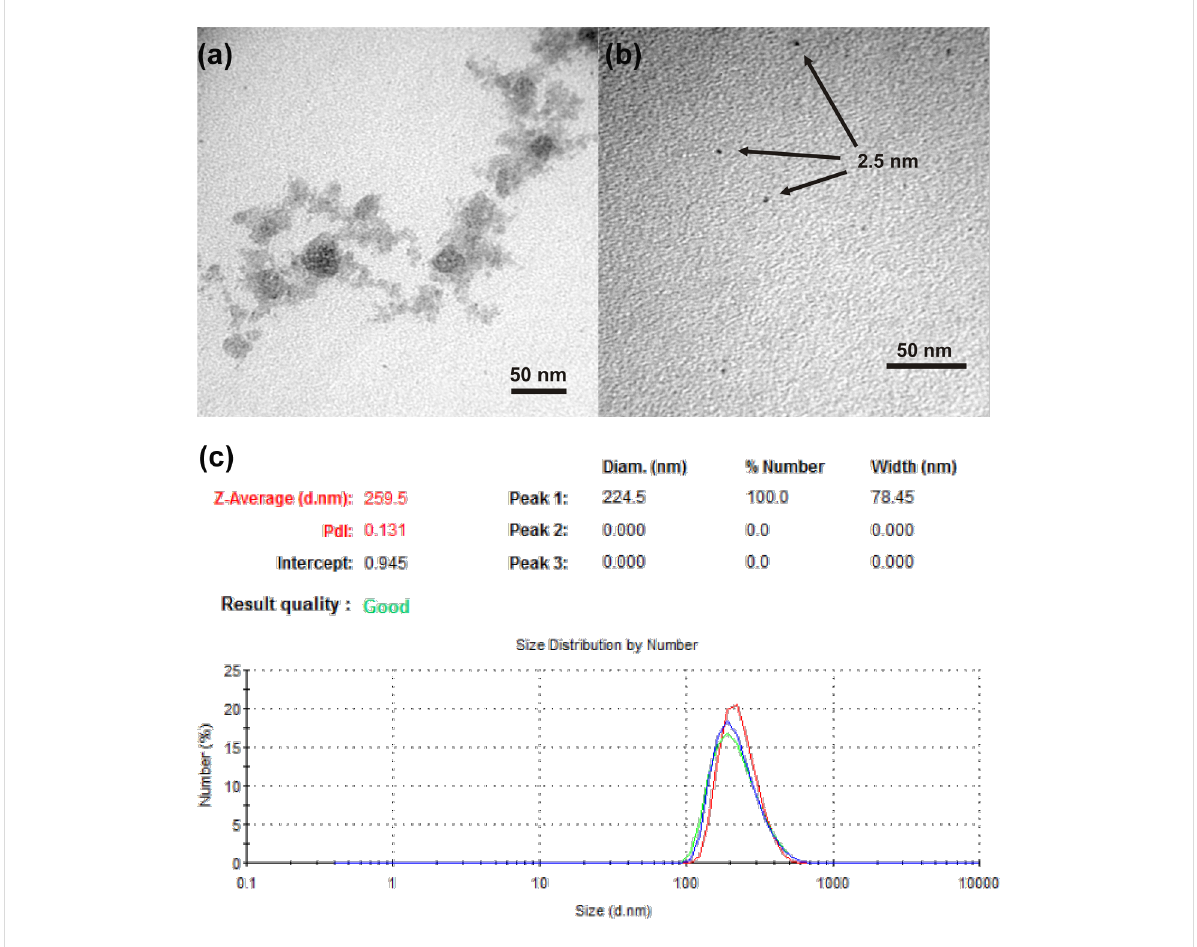
Figure 2: Transmission electron micrographs (TEM) (a,b); histogram of the particle size distribution (c) of 2h solid isoindigo nanoparticles